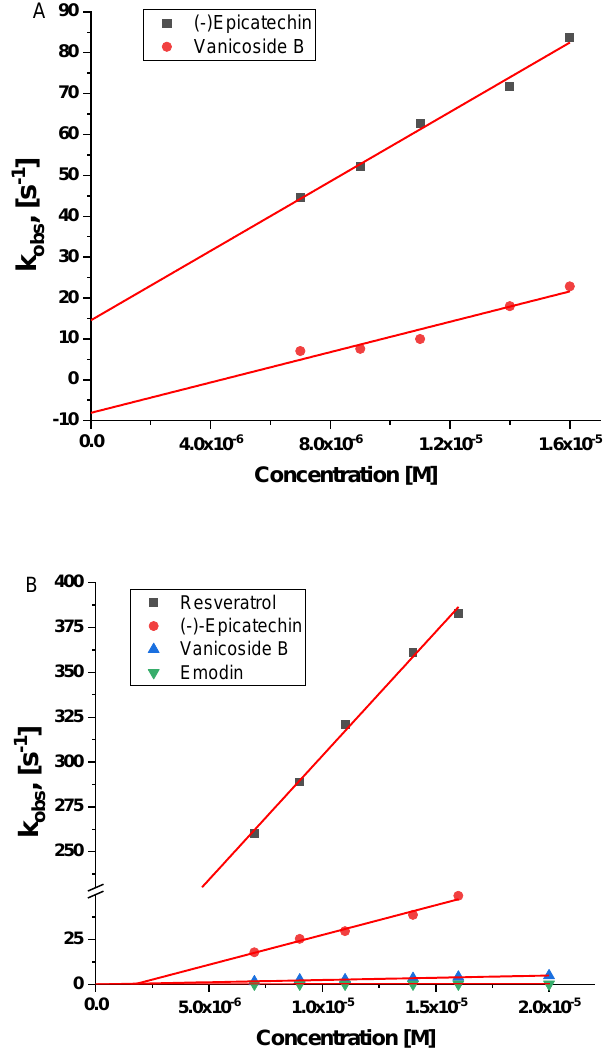
Figure 5. Plots of k obs vs. concentration of selected polyphenols for formation ( A ) and decay ( B ) of Compound II of LPO. Experimental conditions: 0.02 M phosphate buffer pH = 6, 15 ◦ C; ( A ) (LPO) = 1 µ M, (H 2 O 2 ) = 1 µ M; ( B ) (LPO) = 1 µ M, (H 2 O 2 ) = 0.75 µ M.